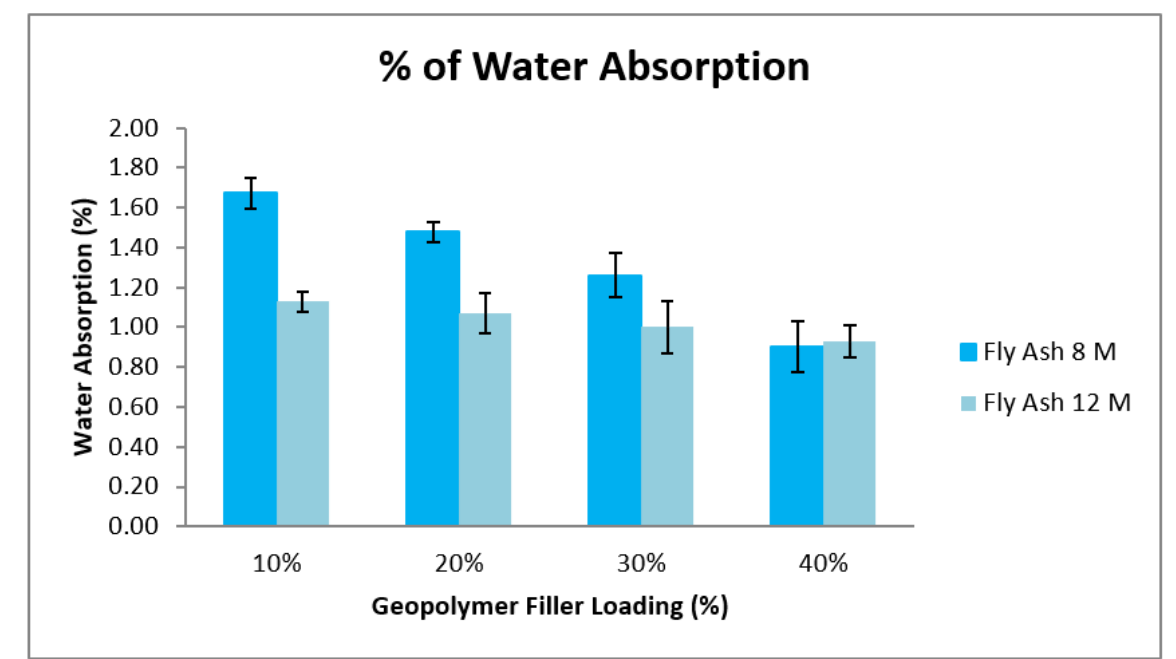
Figure 9. Comparison graph of % water absorption between samples.